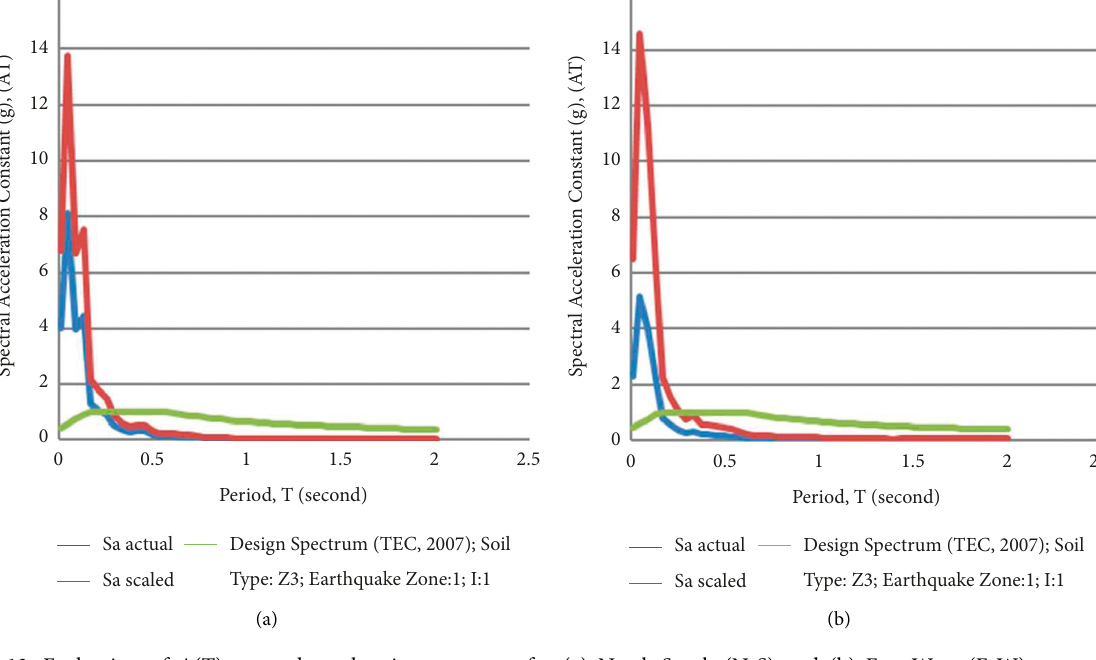
Figure 13: Evaluation of A(T) spectral acceleration constants for (a) North-South (N-S) and (b) East-West (E-W) components of earthquake with epicenter at Sivas ( M D :